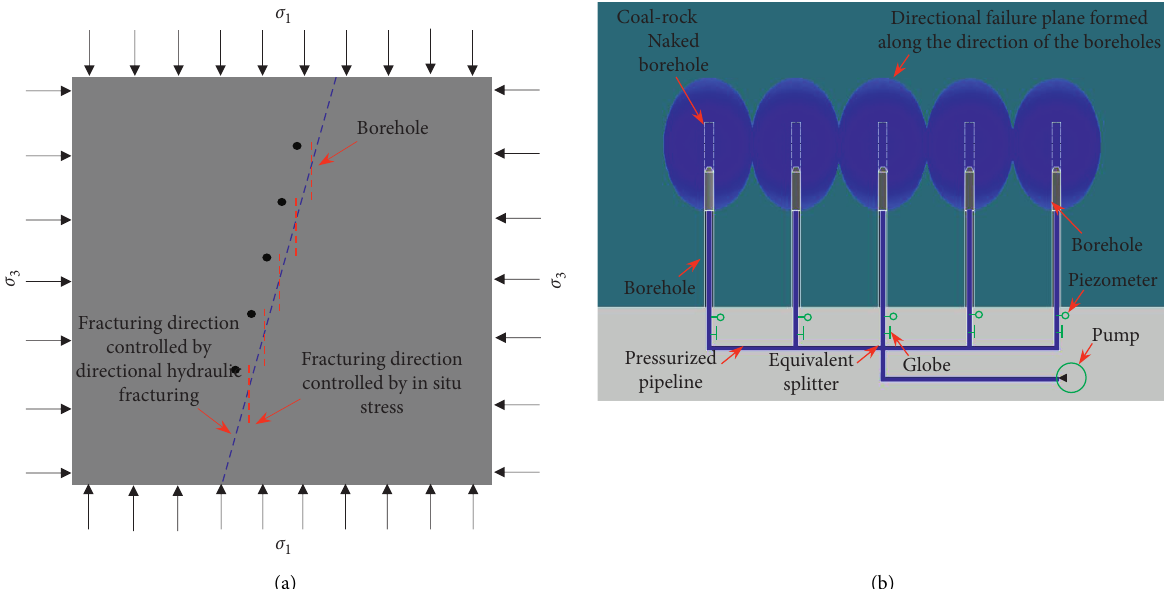
Figure 1: The technical principle and process of directional hydraulic fracturing controlled by dense linear multi-boreholes. (a) Vertical view. (b) Horizontal view